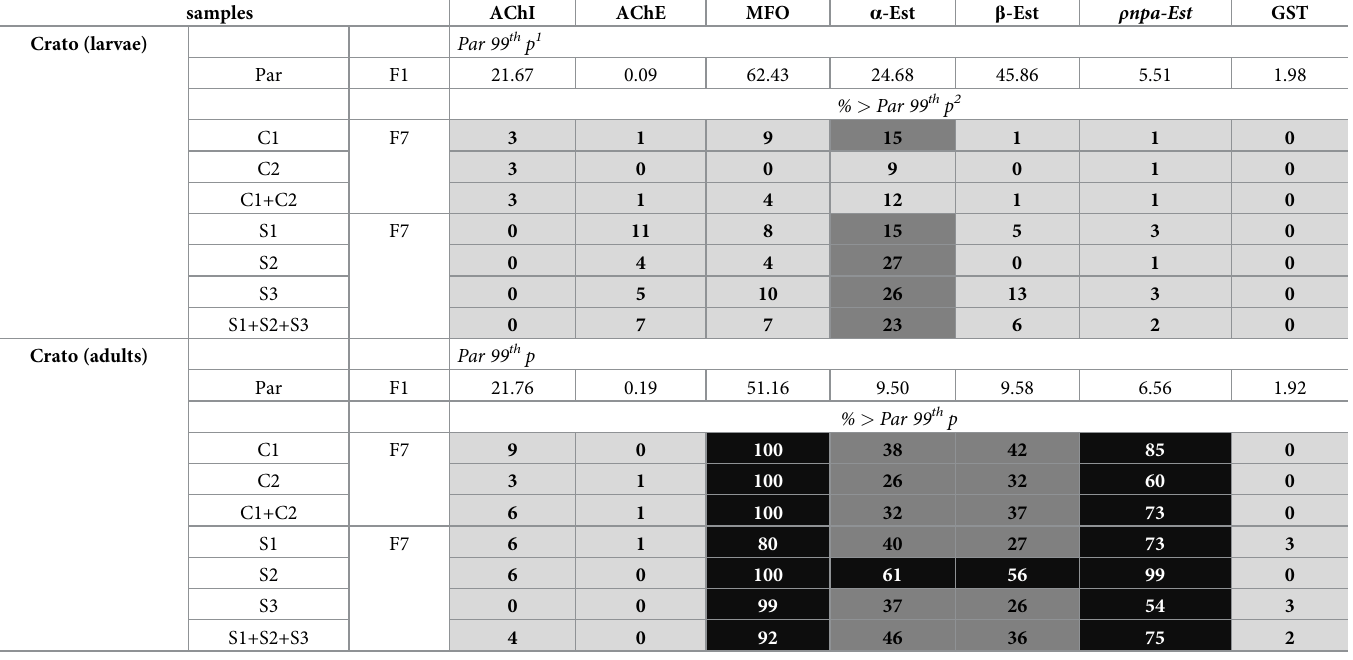
Details as in Table 3